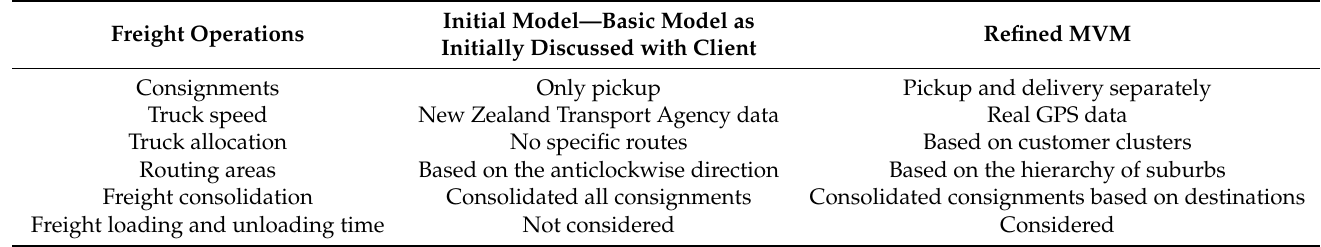
Table 4. Initial and refined models showing assumptions and structure.